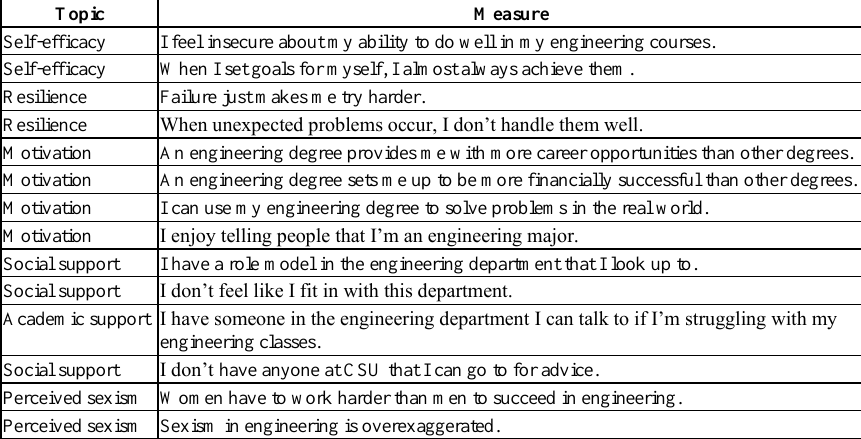
Table 1. Summary of